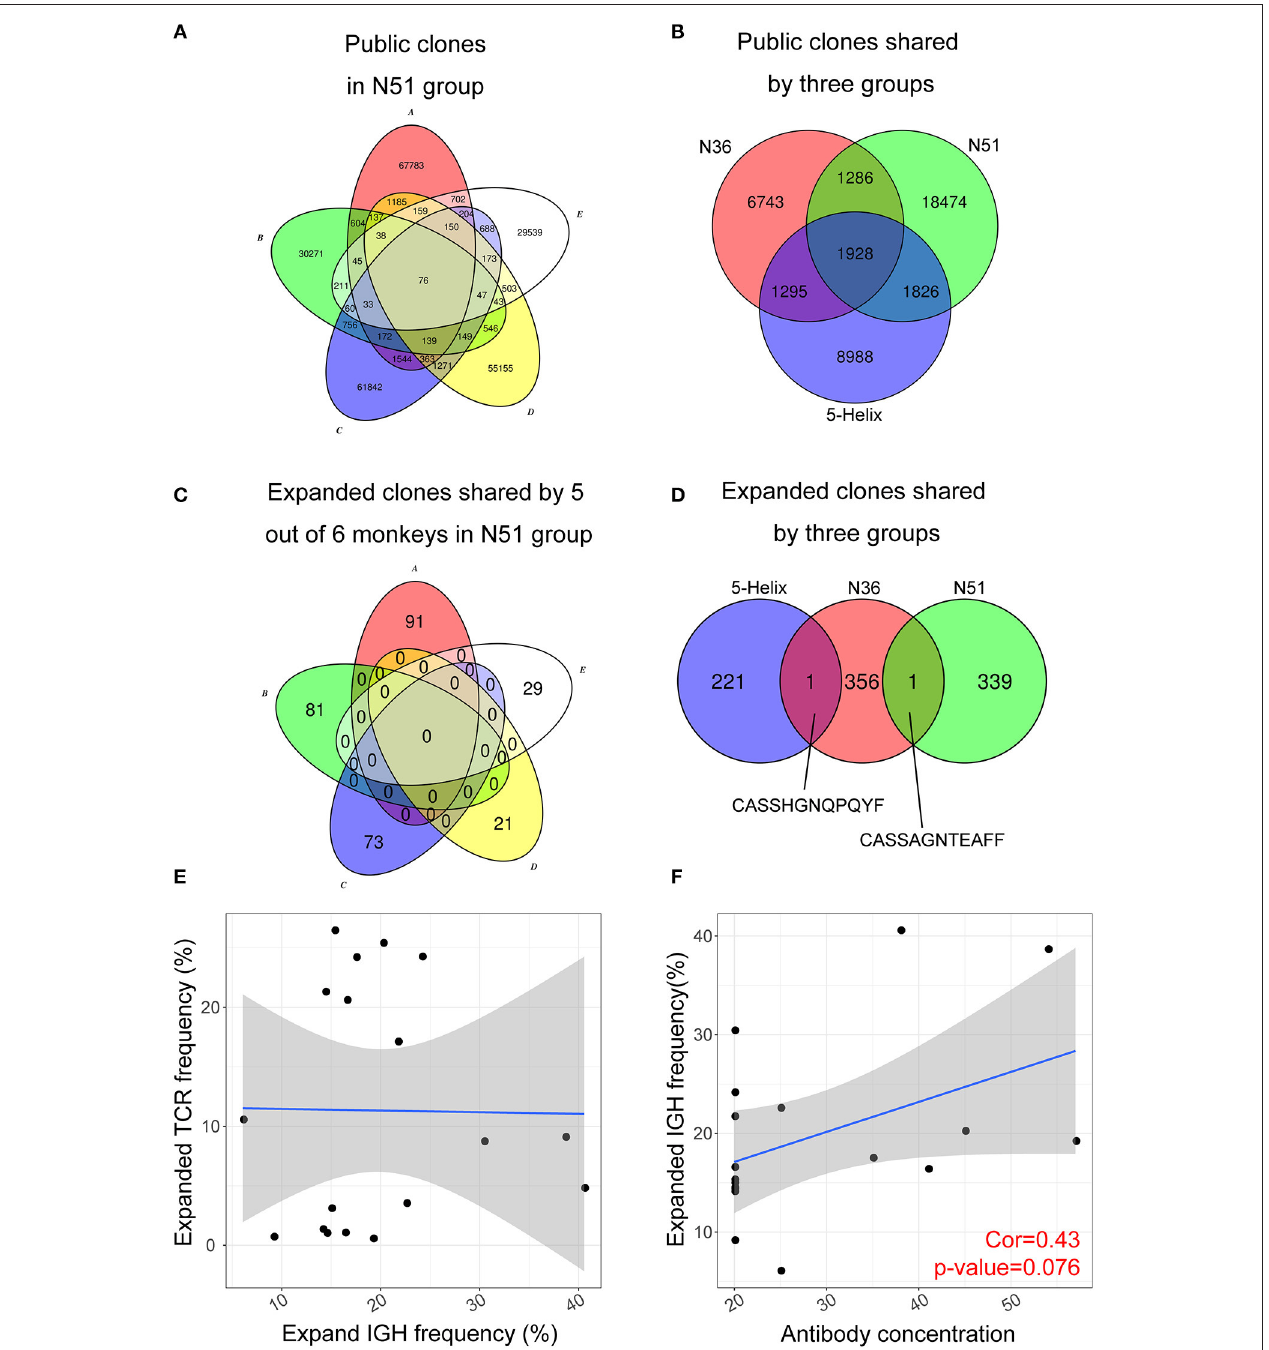
FIGURE 5 | Public expanded TCR clones among vaccination groups. (A) Public non-induced TCR clones shared by 5 macaques in the N51 group (B). Public non-induced TCR clones shared by three vaccine groups. (C) Public expanded TCR clones shared by 5 maracas in the N51 group (D). Public expanded TCR clones shared by three vaccinated groups. The 6th macaques were not plotted for the simplicity of the graph in A and C (E). The correlation between frequencies of expanded IGH clones and expanded TCR clone (F). The correlation between antibody titer and expanded IGH clone